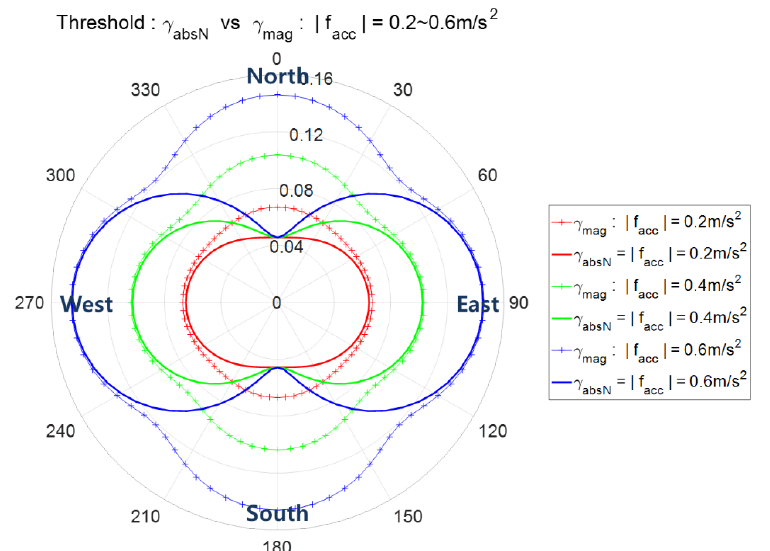
Figure 9. The threshold of spoofing detection γ mag and γ absN according to 𝒇 𝒂𝒄𝒄 , the angle denotes the direction of 𝒇 𝒂𝒄𝒄 , i.e., ∠ 𝒇 𝒂𝒄𝒄 .